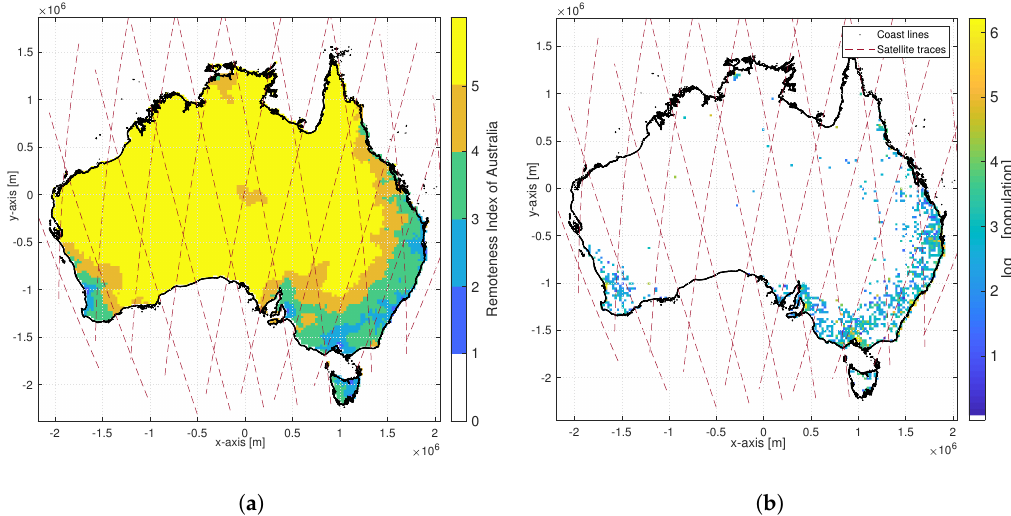
Figure 6. ( a ) Remoteness index and ( b ) IoT population based on human population. The higher value represents a higher level of remoteness. The red dash line is the satellite track over a week [32]. ( a ) Remoteness index based on Reference [32]. ( b ) Number of IoT devices in